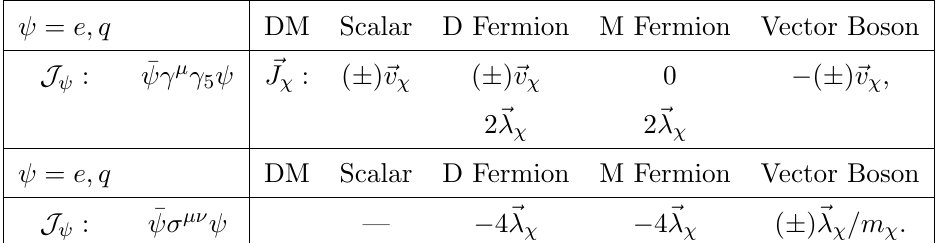
Table 3 . Dark matter matrix elements, ~J (cid:31) , for the di(cid:11)erent currents of table 1 evaluated at q = 0. ‘D’ and ‘M’ Fermions refer to ‘Dirac’ and ‘Majorana’ respectively.